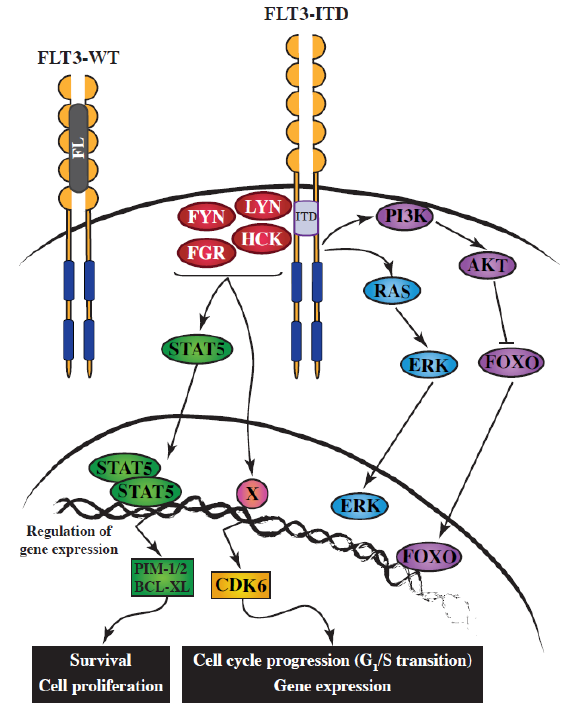
Figure 1. Simplified schematic representation of the implication of SRC-family kinases (SFKs) downstream of FLT3-ITD in acute myeloid leukemia (AML). FLT3 ligand (FL) binds the monomeric form of FLT3-WT, triggering its dimerization, which results in its autophosphorylation. Activated FLT3-WT then initiates multiple signaling transduction pathways. The aberrant activation of FLT3-ITD leads to the constitutive activation of SFKs, which are responsible for (1) STAT5 tyrosine phosphorylation, dimerization, and its subsequent translocation to the nucleus; and (2) the upregulation of CDK6 expression, in part through increased transcription. STAT5 and CDK6 are essential effectors of the FLT3-ITD oncoprotein.